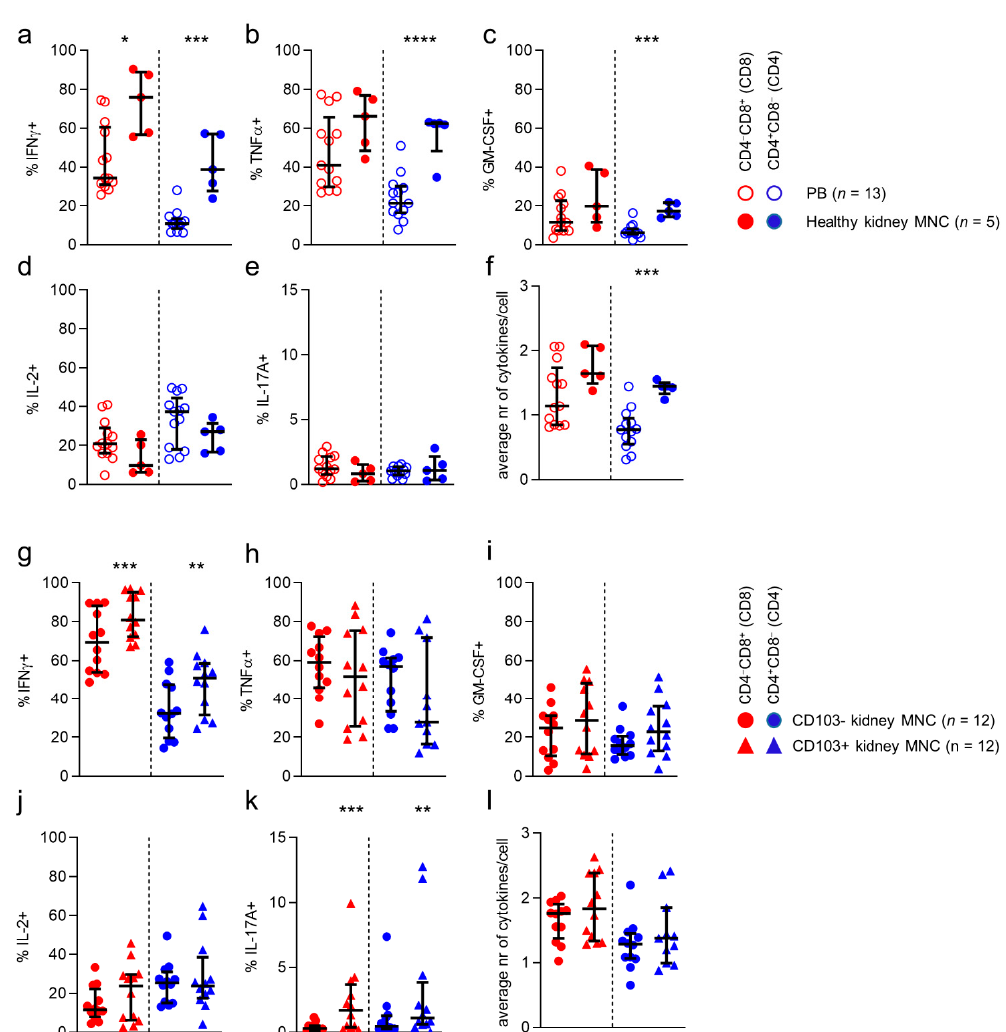
Figure 7. CD4 T cells in kidney tissue are more often polyfunctional than their counterparts in blood. ( a – e ) Percentage of IFN γ -( a ), TNF α -( b ), GM-CSF-( c ), IL-2-( d ) and IL-17A-( e ) producing CD8 (red) and CD4 (blue) T cells derived from peripheral blood (PB) and healthy kidney after 4 hr stimulation with PMA and ionomycin (median with IQR in black). ( f ) The average number of cytokines produced by CD8 and CD4 T cells derived from PB and healthy kidney (median with IQR in black). ( g – k ) Percentage of IFN γ -( a ), TNF α -( b ), GM-CSF-( i ), IL-2-( j ) and IL-17A-( k ) producing CD103 − and CD103 + CD8 (red) and CD4 (blue) T cells derived from kidney after 4 hr stimulation with PMA and ionomycin (median with IQR in black). ( l ) The average number of cytokines produced by CD103- and CD103+ CD8 and CD4 T cells derived from kidney (median with IQR in black). Statistical comparisons used: ( a – d ) Mann-Whitney U-test ( e , f ) Wilcoxon signed rank test. Only significant p-values are displayed: * p < 0.05, ** p ≤ 0.01, *** p ≤